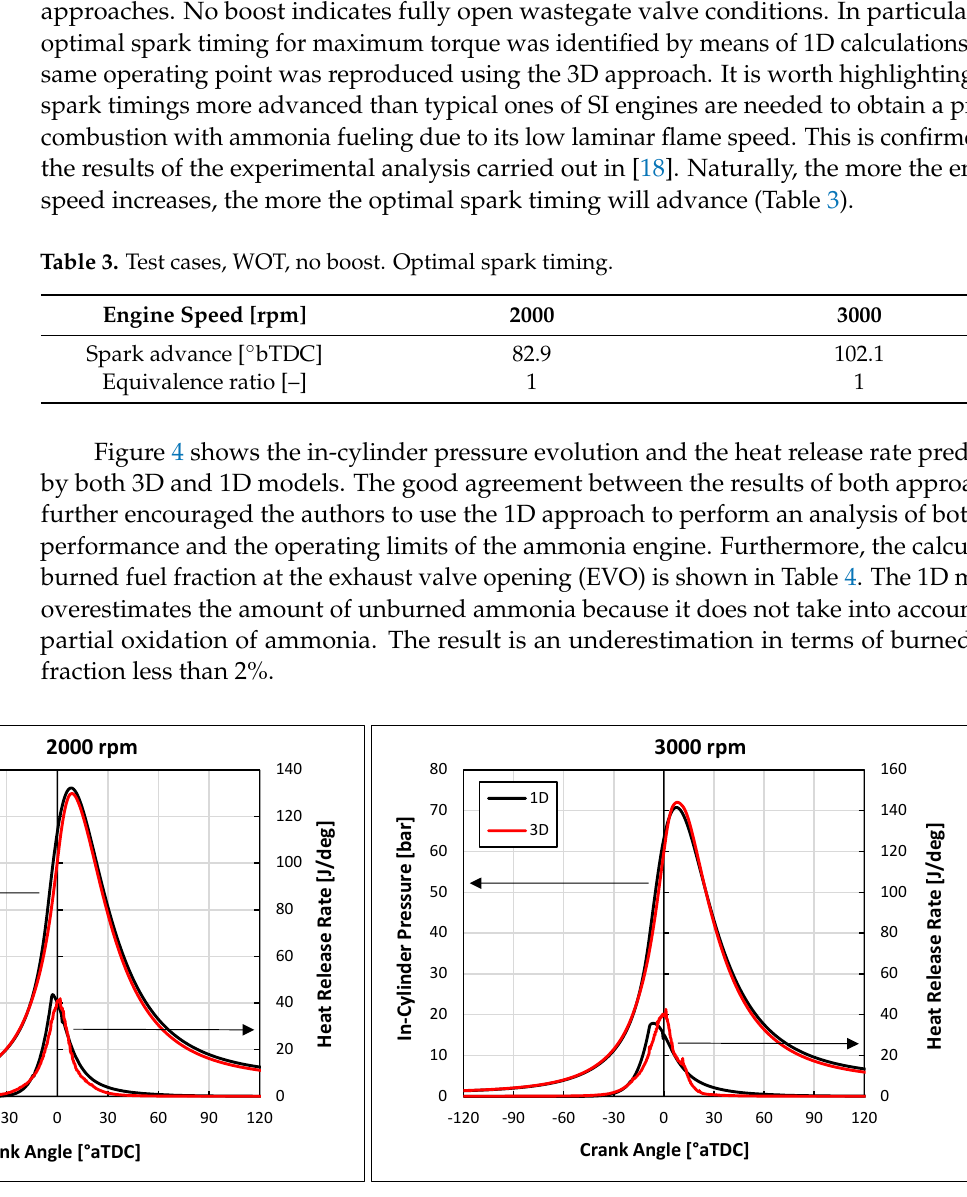
Figure 4. In-cylinder pressure and heat release rate for both 2000 and 3000 rpm operating points, WOT. Comparison between 1D and 3D results. φ = 1, no boost. Table 4. Burned fuel fraction at EVO calculated by both 3D and 1D model. WOT, no boost, optimal spark timing.